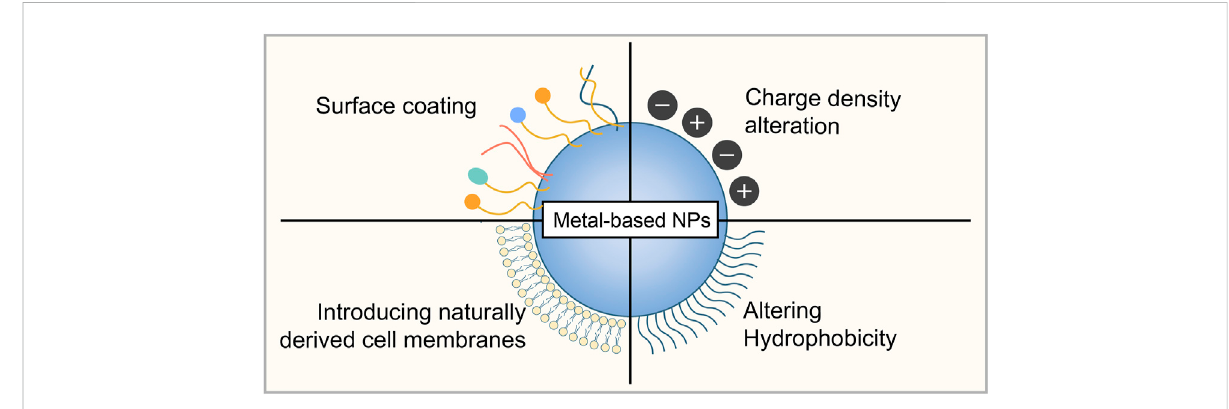
FIGURE 3 Strategies tomitigatemetal-basedNP toxicity. Surface coating, surfacechemistry modi fi cationsbyaltering chargedensity andhydrophobicity, and introducing naturally derived cell membranes from several cell types can be used to reduce the potential toxicity of metal-based